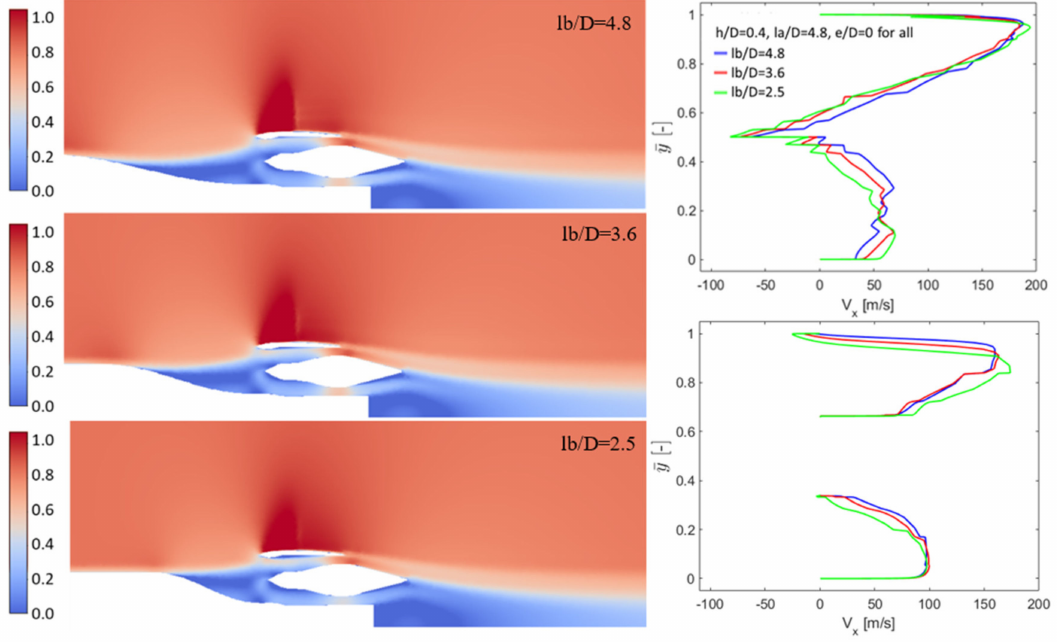
Figure 10. Contours of Mach number. Results of varying intake diffusion lengths l b , 2D